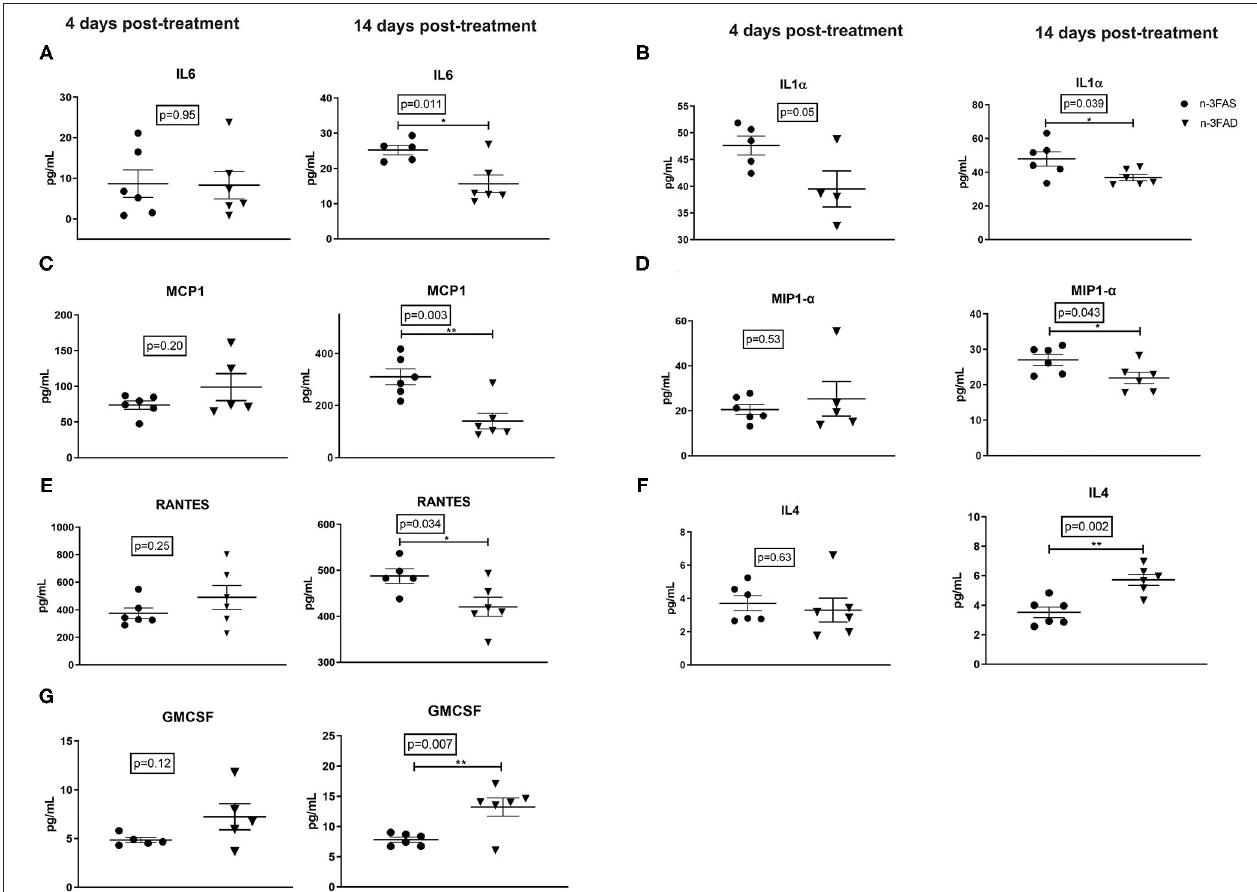
FIGURE 3 | Effects of conditioning and treatment on lung cytokine levels. (A) IL-6, (B) IL-1 α , (C) MCP-1, (D) MIP-1 α , (E) RANTES, (F) IL-4, and (G) GM-CSF. The data are represented as mean ± SEM of n = 6 mice/group and representative of two independent experiments. Unpaired two-tailed t -tests were used to compare means, significance at * p < 0.05, ** p < 0.01. IL, interleukin; IL-1 α , interleukin 1 alpha; MIP-1 α , macrophage inflammatory protein 1-alpha; MCP-1, Monocyte chemoattractant protein-1; GM-CSF, granulocyte-macrophage colony-stimulating factor; RANTES, Regulated on Activation, Normal T Cell Expressed and Secreted; n-3FAS, omega-3 fatty acid- sufficient diet group; n-3FAD, omega-3 fatty acid-deficient diet